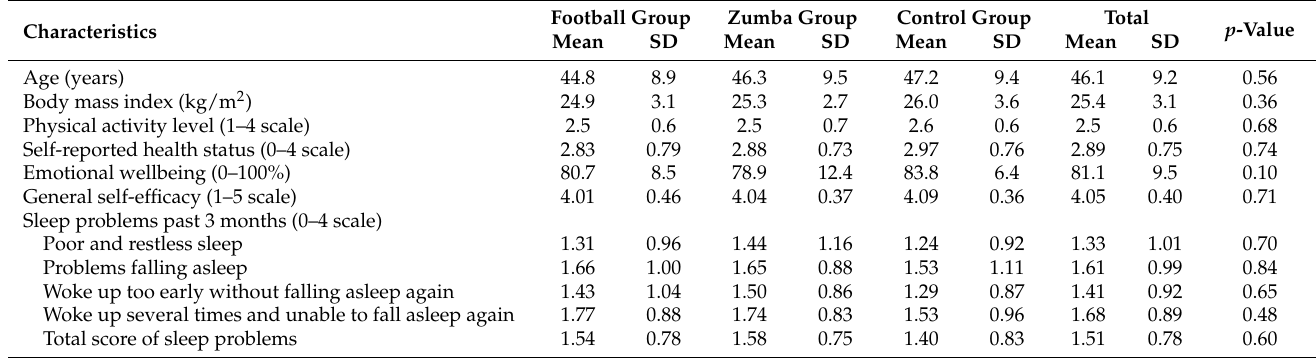
Table 1. Subject characteristics at baseline. The table presents age, anthropometry, physical activity level, self-reported health status, perceived emotional wellbeing, general self-efficacy, as well as self-reported sleep problems for the football group ( n = 35), the Zumba group ( n = 34), and the control group ( n = 34), respectively. The p -values refer to comparisons between all